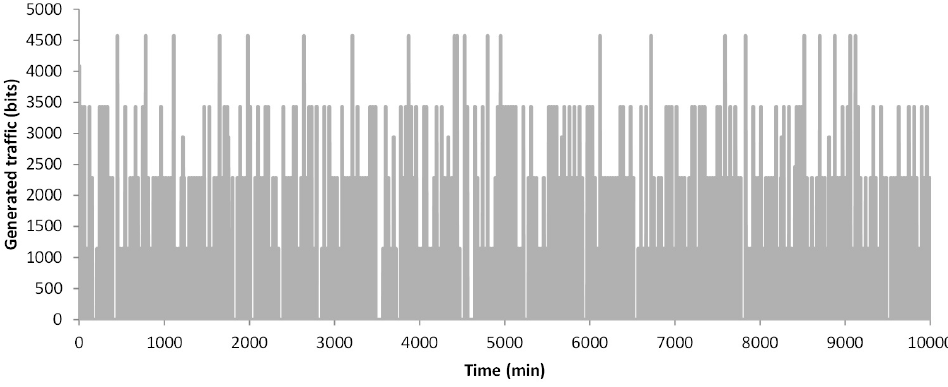
Figure 7. Generated traffic by a node used by a person with cardiac affection.